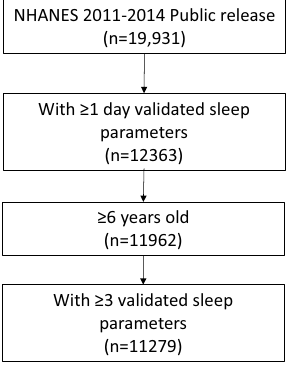
Figure 1. Flowchart for inclusion of study